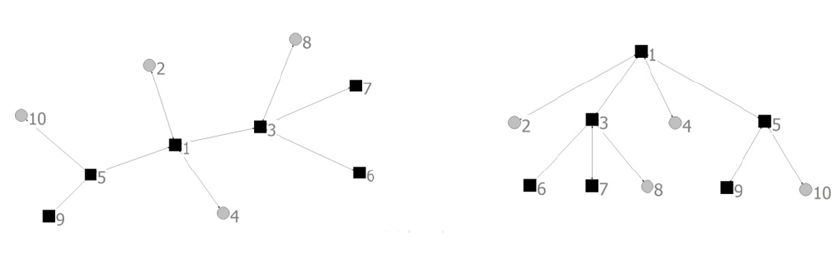
Figure 8. Branching process.